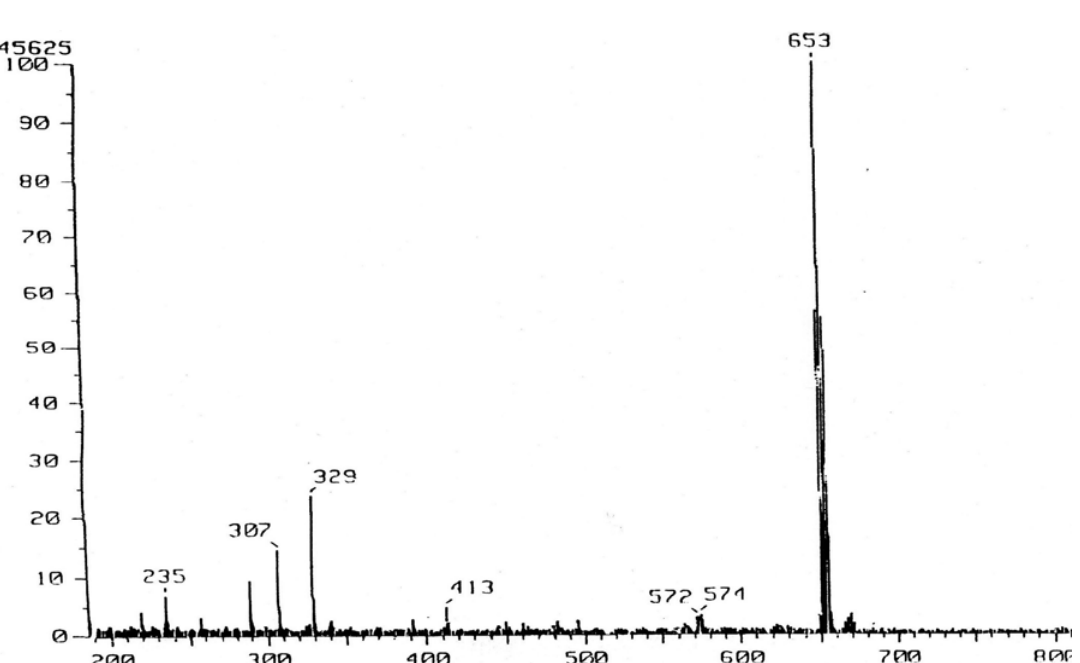
Figure 3. Mass spectrum (FAB) of VIII